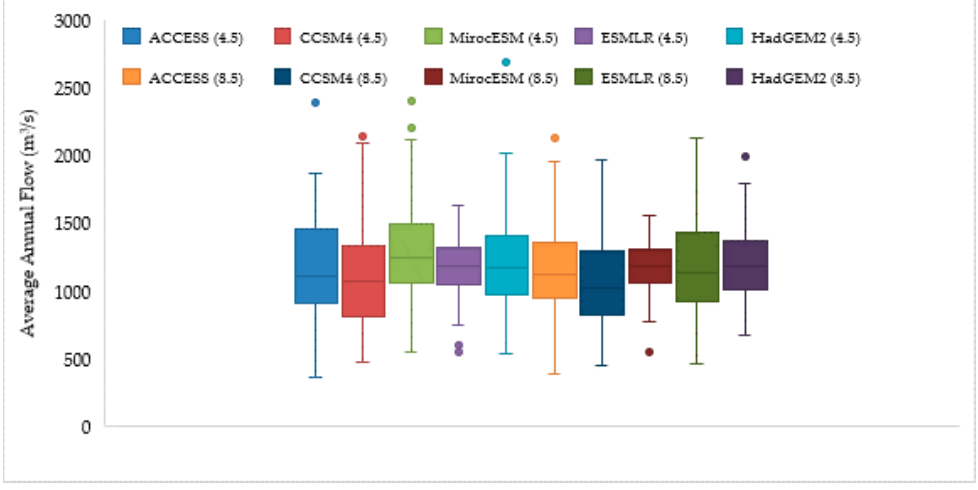
Figure 15. Box-plot representation of average annual flow under RCP-4.5 and RCP-8.5. Table A1 represents the peak, mean, and low streamflow from the year 2021 to 2100 under the RCP-4.5 emission scenario. The peak flows occur commonly in the summer season (during June, July, and August) due to the melting of snow from the northern part of the watershed, and low flows usually occur during the winter season due to less snow melting. HadGEM2 depicts the maximum